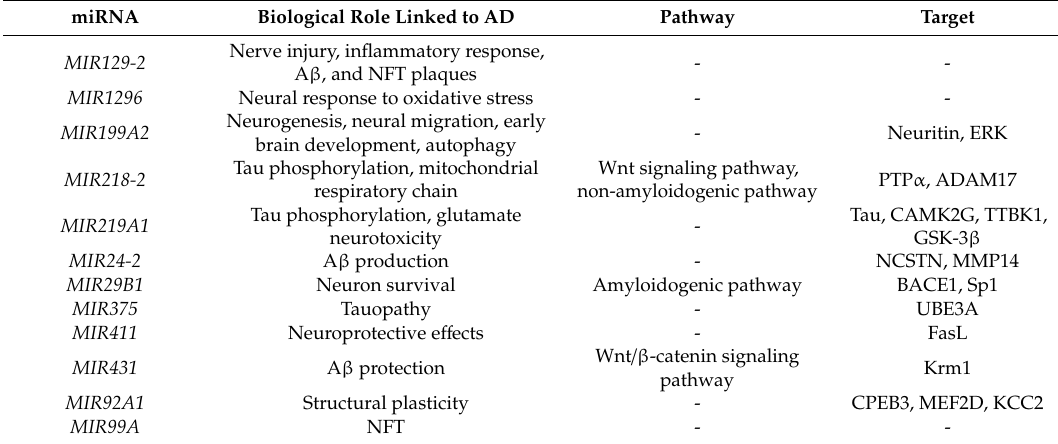
Table 2. Role of miRNAs that were up- and downregulated between healthy individuals and AD patients. miRNA Biological Role Linked to AD Pathway Target Nerve injury, inflammatory response, MIR129-2 - - A β , and NFT plaques MIR1296 Neural response to oxidative stress - - Neurogenesis, neural migration, early MIR199A2 - Neuritin, ERK brain development, autophagy Tau phosphorylation, mitochondrial Wnt signaling pathway, MIR218-2 PTP α , ADAM17 respiratory chain non-amyloidogenic pathway Tau, CAMK2G, TTBK1, Tau phosphorylation, glutamate MIR219A1 - neurotoxicity GSK-3 β MIR24-2 A β production - NCSTN, MMP14 MIR29B1 Neuron survival Amyloidogenic pathway BACE1, Sp1 MIR375 Tauopathy - UBE3A MIR411 Neuroprotective e ff ects - FasL Wnt / β -catenin signaling MIR431 A β protection Krm1 pathway MIR92A1 Structural plasticity - CPEB3, MEF2D, KCC2 MIR99A NFT -